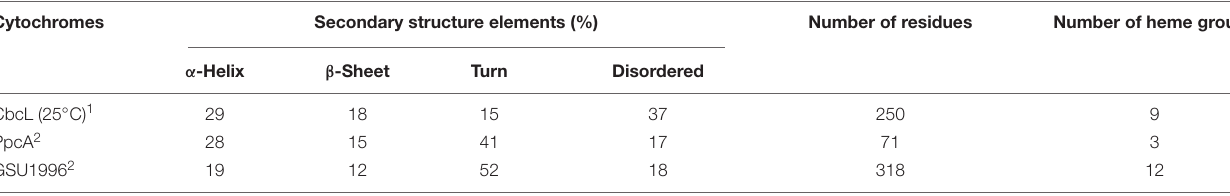
TABLE 1 | Structural features of cytochromes CbcL, PpcA and GSU1996 from G. sulfurreducens . Cytochromes